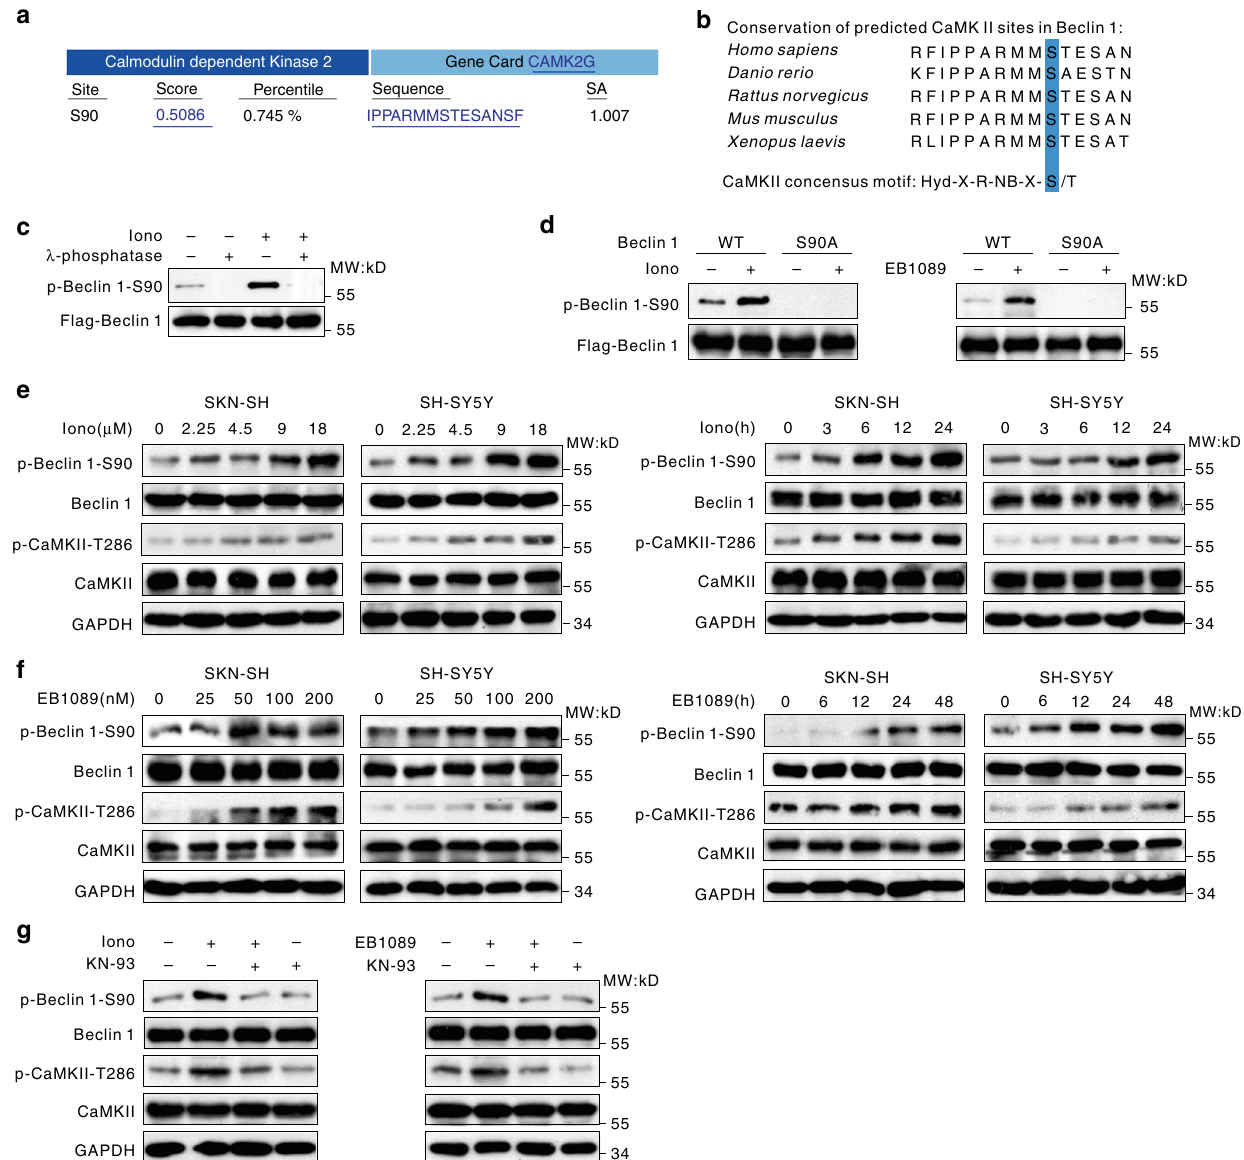
Fig. 1 CaMKII activity affects the phosphorylation of Beclin 1 at Ser90. a Based on an analysis of the Beclin 1 amino acid sequence, Ser90 of Beclin 1 is strongly predicted to be a CaMKII phosphorylation site. b The predicted CaMKII phosphorylation sites in Beclin 1 are highly conserved during evolution. Putative CaMKII phosphorylation sites are indicated with a blue background. c The speci fi city of the anti-phospho-Ser90 Beclin 1 antibody. HEK293T cells were transiently transfected with plasmids encoding Flag-Beclin 1-WT, and the cells were incubated for 1h at 30°C in the absence or presence of ionomycin. The lysates of cells were incubated with or without λ -phosphatase. Flag-tagged proteins were immunoprecipitated and analyzed. d Ca (2+) mobilizing agents regulate Beclin 1 Ser90 phosphorylation. HEK293T cells were transiently transfected with the indicated plasmids for 48h and then lysed, and Beclin 1 was precipitated using an anti-Flag antibody. The precipitates were analyzed by western blotting using an anti-phospho-Beclin 1-S90 antibody. e Ionomycin- induced phosphorylation of Beclin 1 on Ser90 occurs via a CaMKII-dependent pathway in a time-dependent and concentration-dependent manner. Both cell lines were treated with 6 μ M ionomycin for the indicated periods or with various concentrations of ionomycin for 24h. The cell extracts were analyzed by western blotting. f The EB1089-induced phosphorylation of Beclin 1 on Ser90 occurs via a CaMKII- dependent pathway in a time-dependent and concentration-dependent manner. Both cell lines were treated with 100nM EB1089 for the indicated periods or various concentrations of EB1089 for 24h. The cell extracts were analyzed by western blotting. g The inhibition of the phosphorylation of Beclin 1 by a CaMKII inhibitor. SK-N-SH cells were untreated or treated with 6 μ M ionomycin, 100nM EB1089, or 10 μ M KN-93 for 24h. The cell extracts were analyzed by western